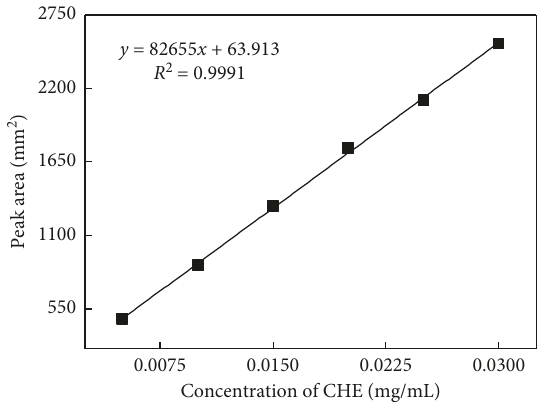
Figure 2: HPLC standard curve of